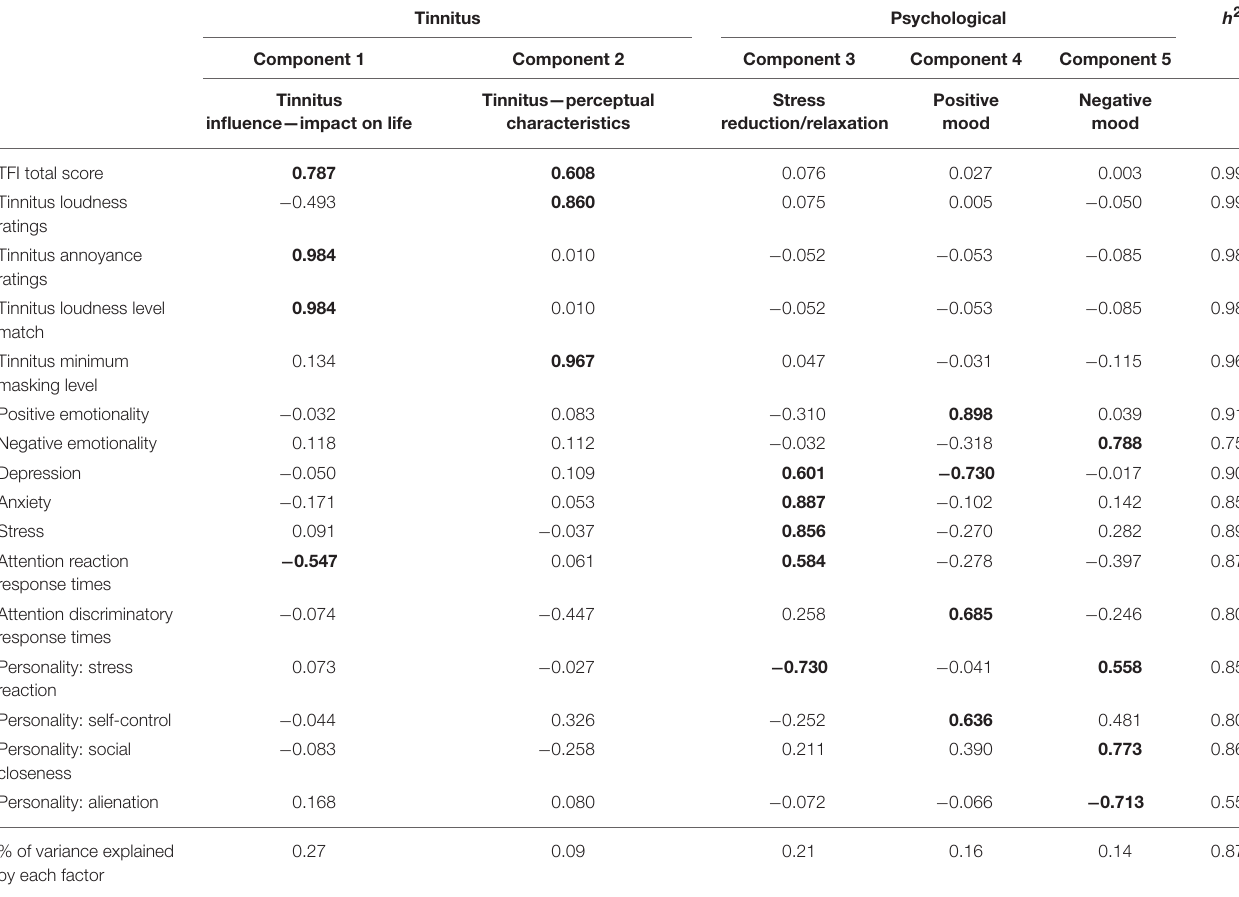
TABLE 4 | Principal components analysis (with direct oblimin rotation) loadings of intervention study